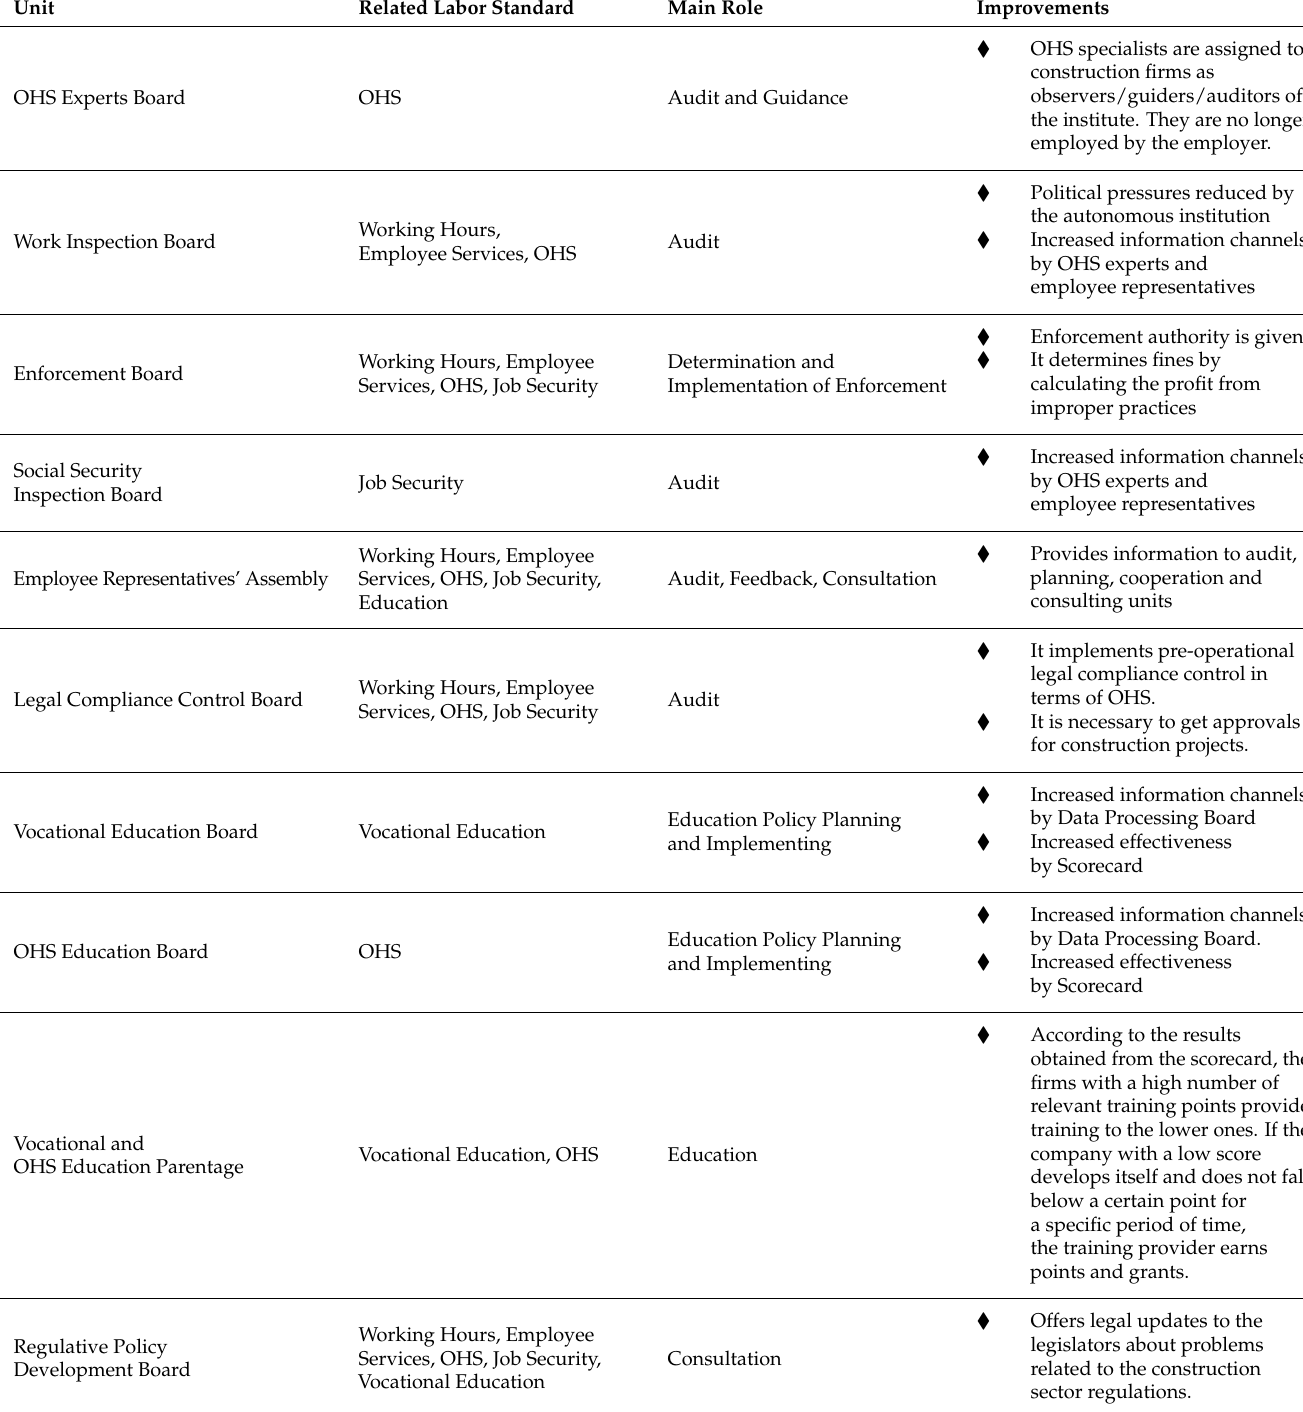
Table 5. The Proposed Organization’s Main Roles and Innovative